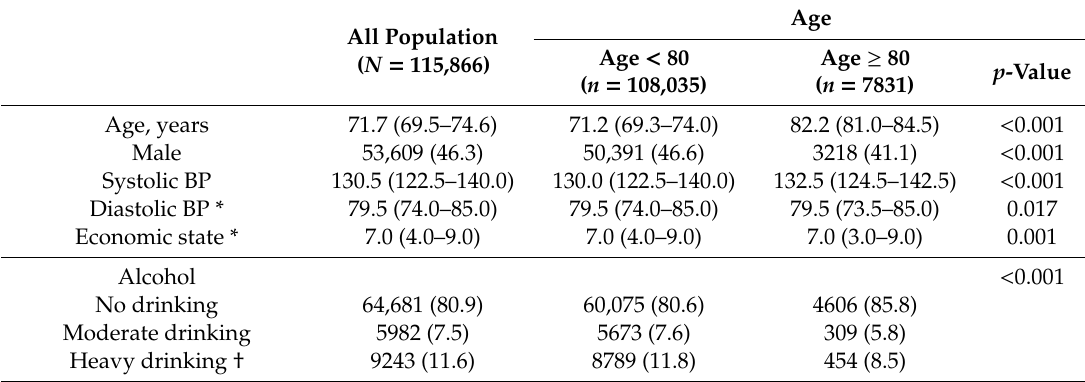
Table 1. Comparison of clinical characteristics between the non-octogenarian and the octogenarian